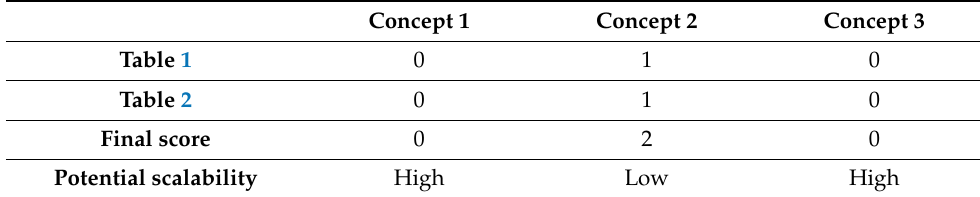
Table 17. Scalability potential. Final